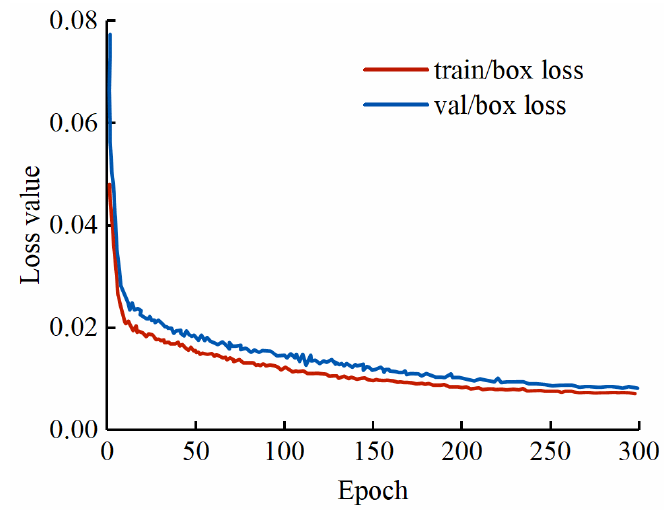
Figure 8. Training and validation loss.